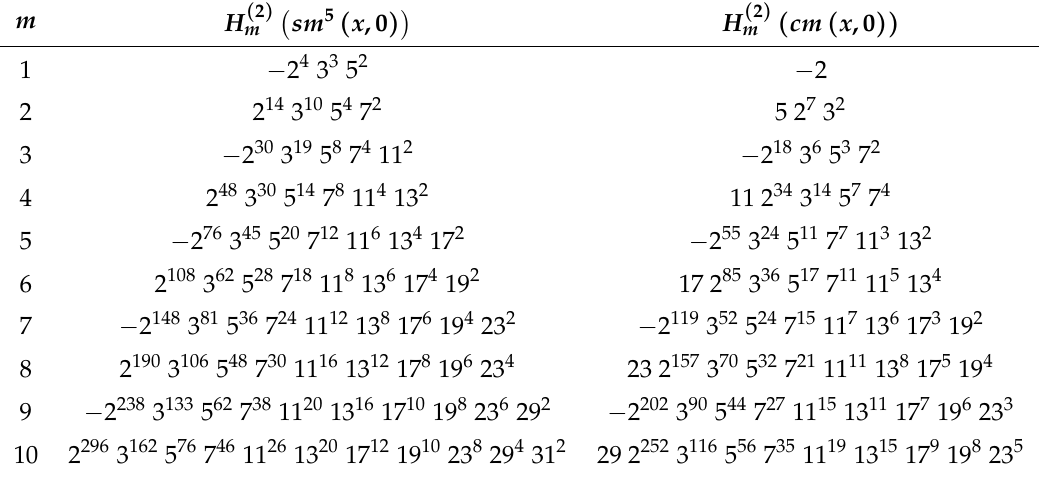
( 2 ) ( . ) of the Dixon elliptic functions sm 5 ( x ,0 ) and cm ( x ,0 ) for m from 1–10. m